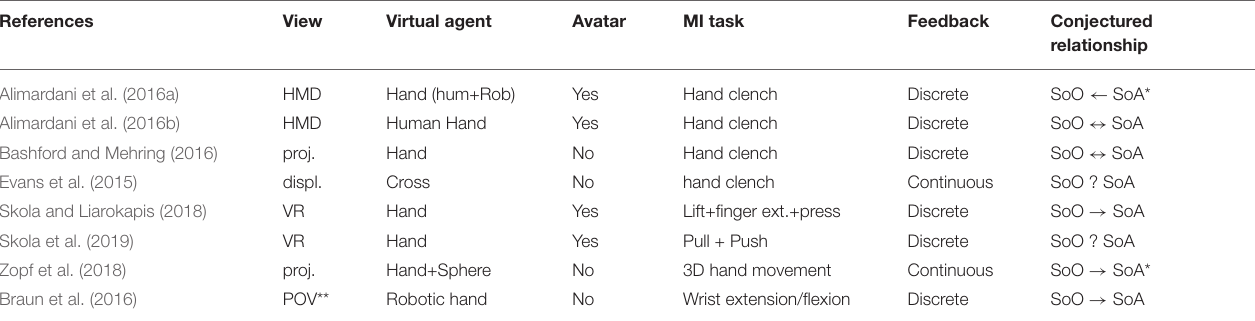
TABLE 1 | Overview of previous work by medium (View), agent representation, whether it included an avatar, motor imagery task and the conjectured relationship between sense of agency and ownership as a result of the study (arrows indicate which factor moderates the other).